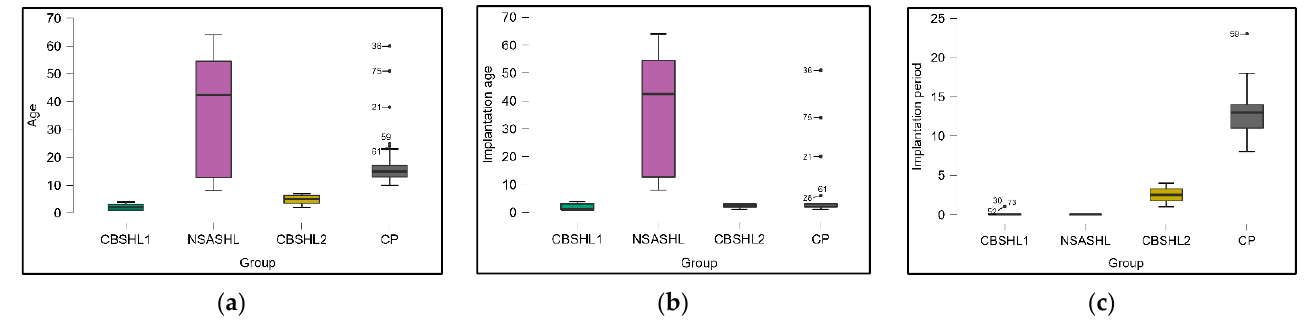
Figure 2. The data dynamics within the four studied groups 𝑁 (cid:3004)(cid:3003)(cid:3020)(cid:3009)(cid:3013)(cid:2869) = 20; 𝑁 (cid:3015)(cid:3020)(cid:3002)(cid:3020)(cid:3009)(cid:3013) = 12; 𝑁 (cid:3004)(cid:3003)(cid:3020)(cid:3009)(cid:3013)(cid:2870) = 4; 𝑁 (cid:3004)(cid:3003) = 41 : (a) the age of patients; (b) the implantation age; ( c ) the implantation period; CBSHL1—patients with congenital bilateral sensorineural hearing loss receiving their first implant; NSASHL—patients with non-congenital severe acquired bilateral sensorineural hearing loss; CBSHL2—patients with congenital bilateral sensorineural hearing loss; CP—previously implanted patients who were hospitalized for the change of processor (control group).